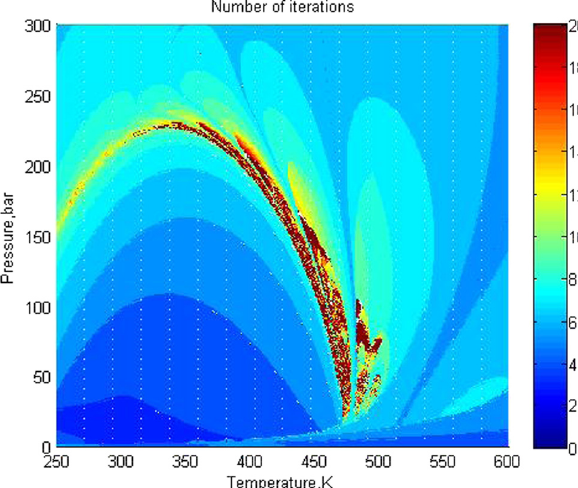
Figure 2: Number of iterations for the Y8 mixture, proposed method with type V initialization.